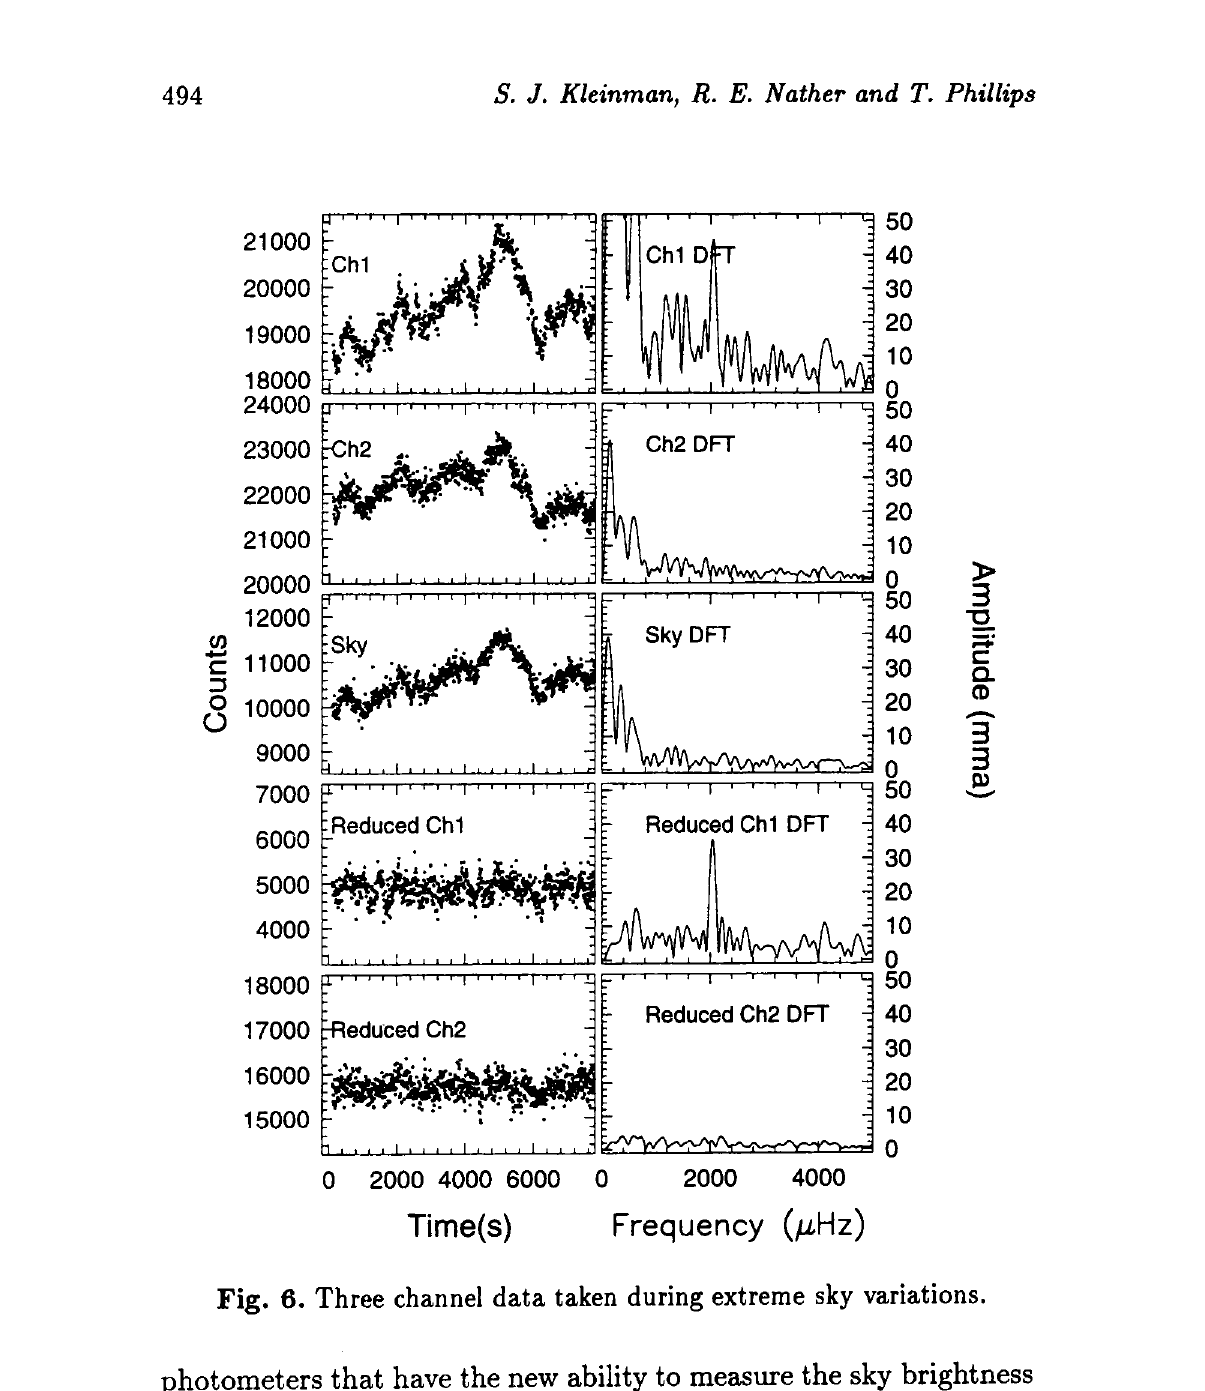
Fig. 6. Three channel data taken during extreme sky